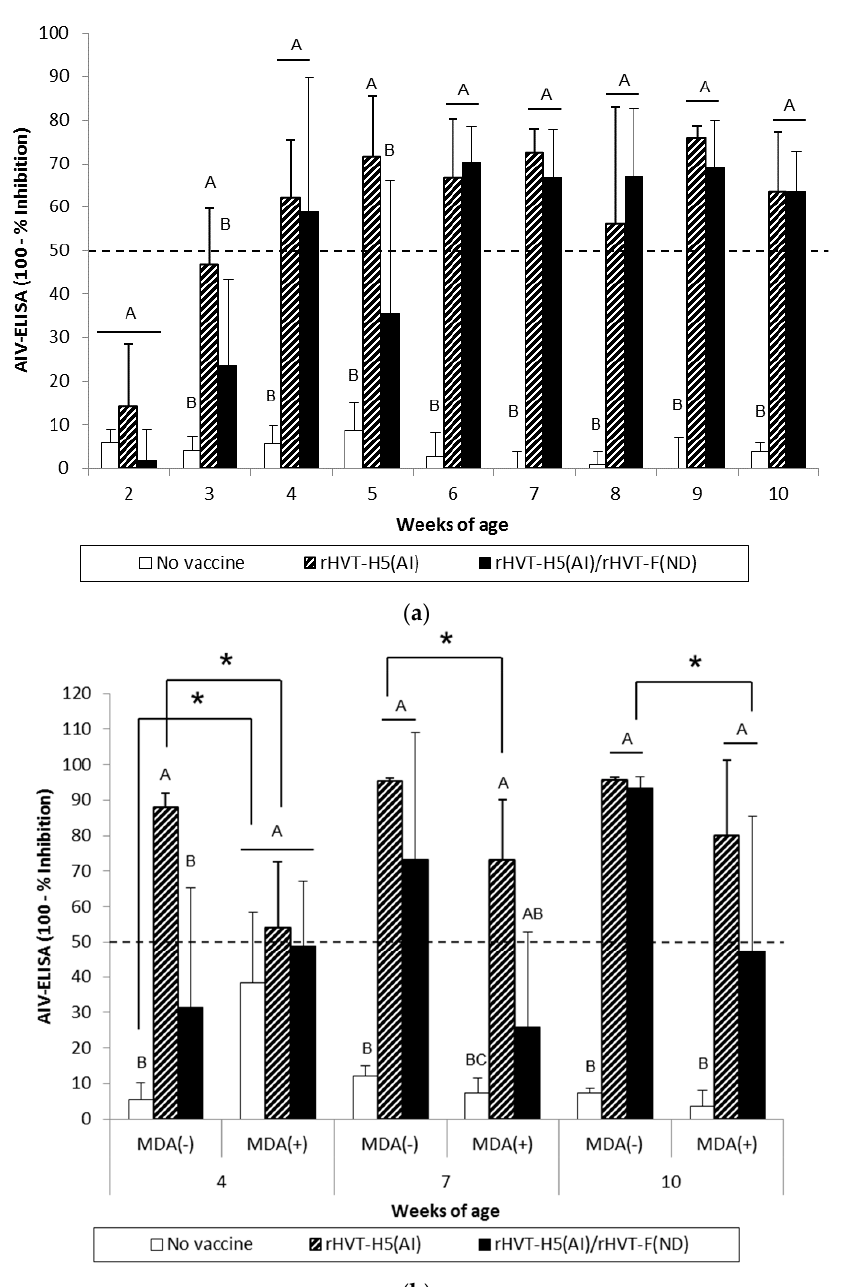
Figure 5. AIV-specific antibody responses measured in H5-ELISAs for WL SPF chickens ( a ) and LBL layer chickens ( b ) vaccinated at day-old (experiments I and II, respectively) with rHVT-F(ND) or both rHVT-H5(AI)/rHVT-F(ND) vaccines. Data represent mean ± standard deviation of antibody titers